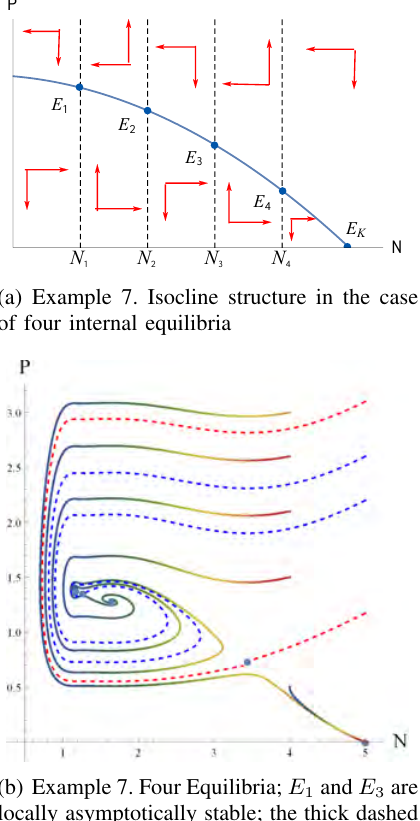
locally asymptotically stable; the thick dashed lines separate the basins of attraction of E 1 , E 3 , and E K . Fig. 13. Dynamics of system (4) in the case of four internal equilibrium points.